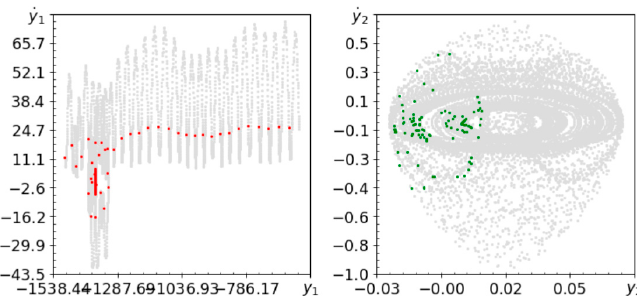
Figure 8. Time history of Lyapunov exponents for ω = 4.94.